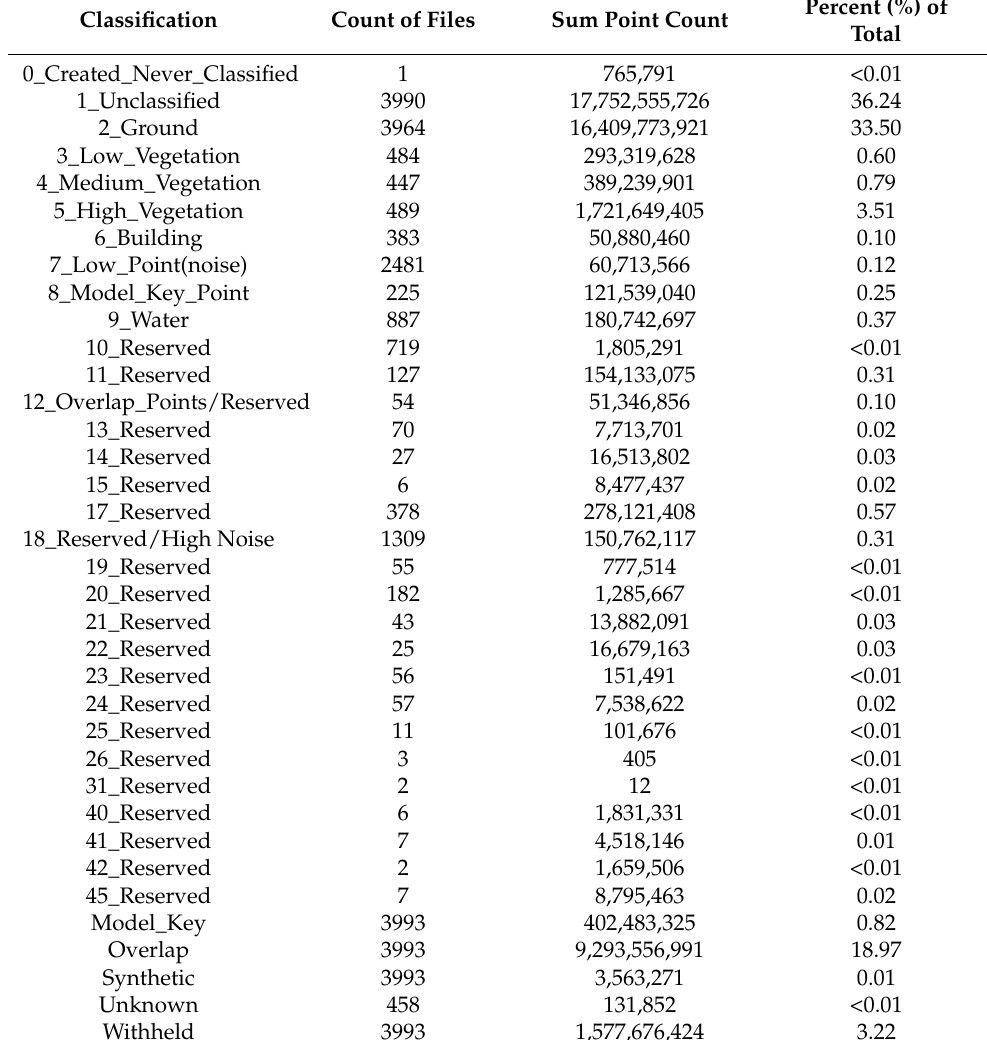
Table 3. Composition of classifications from complete random sample approach.